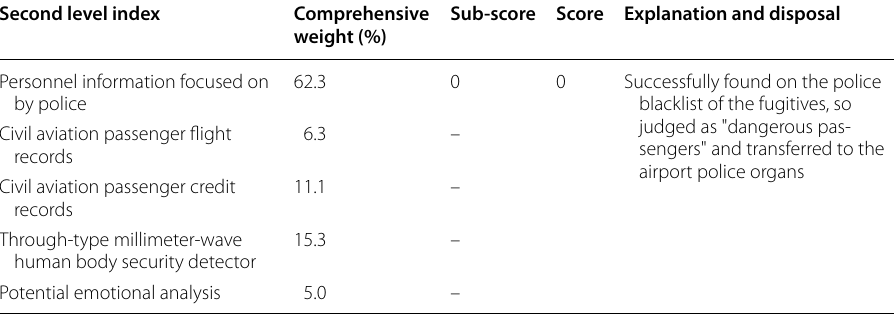
Table 13 Risk assessment results and disposal methods of case 3